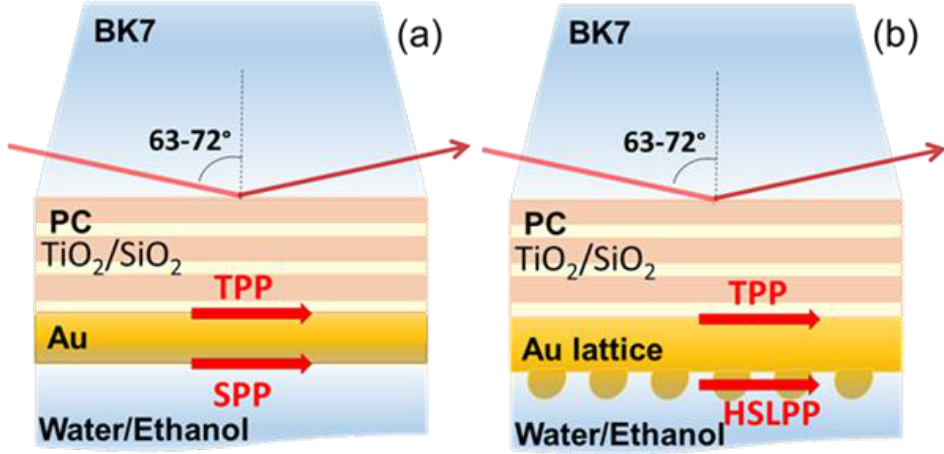
Figure 1. Scheme of excitation configurations of the PC(TiO 2 /SiO 2 )/Au structures for generating the TPP-SPP ( a ) and TPP-HSLPP ( b ) modes by spectroscopic ellipsometry in total internal reflection (TIR).